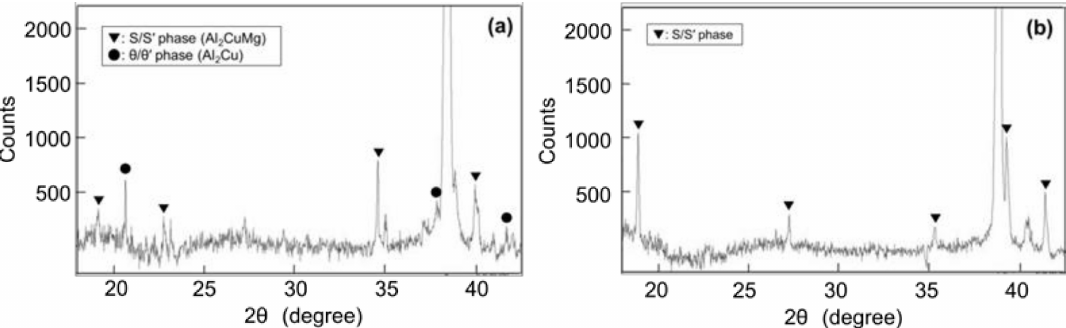
Figure 14. X-ray Diffraction (XRD) patterns; ( a ) Melt-A2024; ( b )